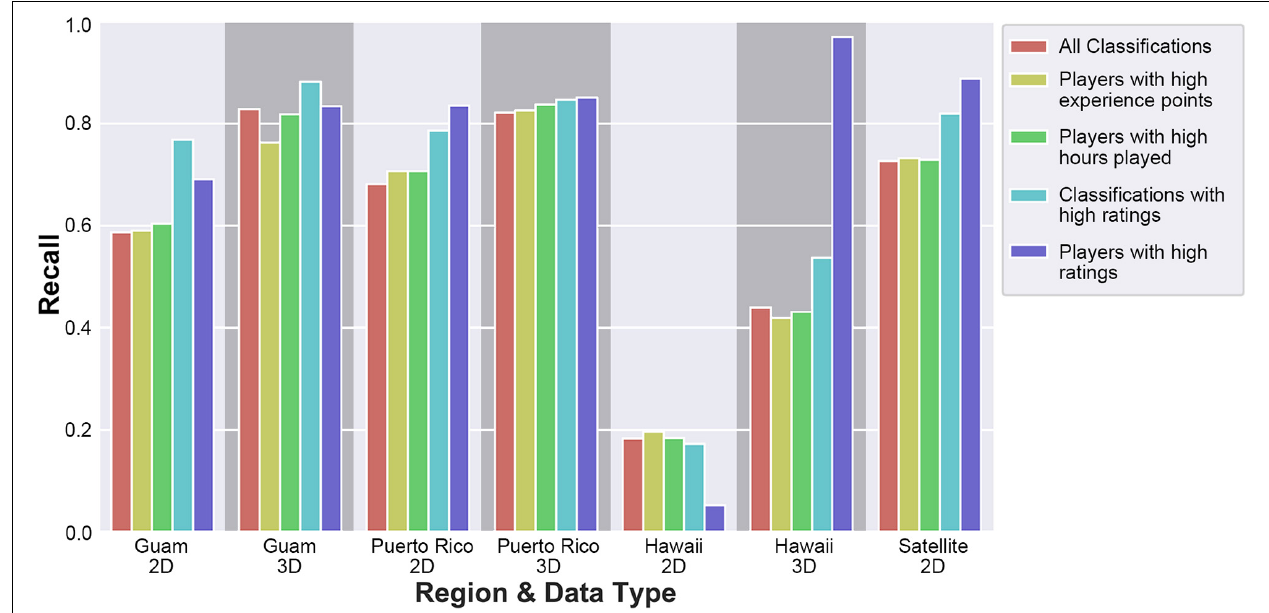
FIGURE 11 | Comparison of recall (accuracy) for 2D versus 3D dataset labeling. Going from 2D labeling to 3D labeling demonstrates a measurable impact of recall, especially in areas with high benthic complexity. ‘All classifications’ applies no filter to the user dataset. ‘Players with high experience points’ filters out players with below 200 in-game experience points. ‘Players with high hours played’ filters out players who have played less than 1 hour. ‘Classifications with high ratings’ filters out classifications with a rating sum at or below 0. Players with high ratings filters out players who have had their classifications rated less than 5 times and players who have an average rating sum below